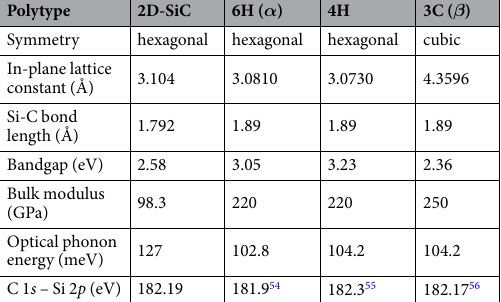
Table 1. Comparison of 2D-SiC properties we calculated to those of the major bulk polytypes reported in the literature (from ref. 53 unless otherwise